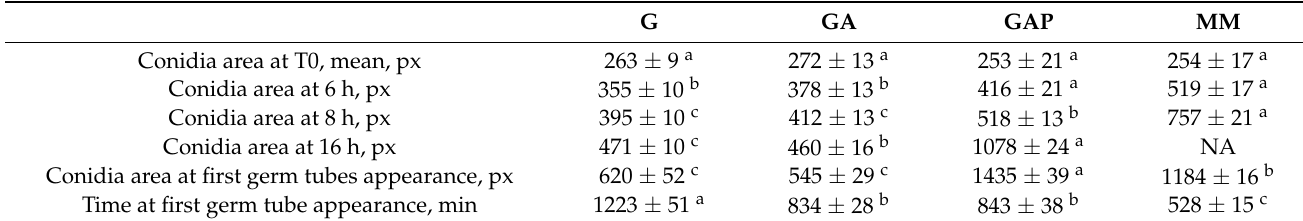
Table 1. Germination parameters in different media G, GA, GAP and MM.